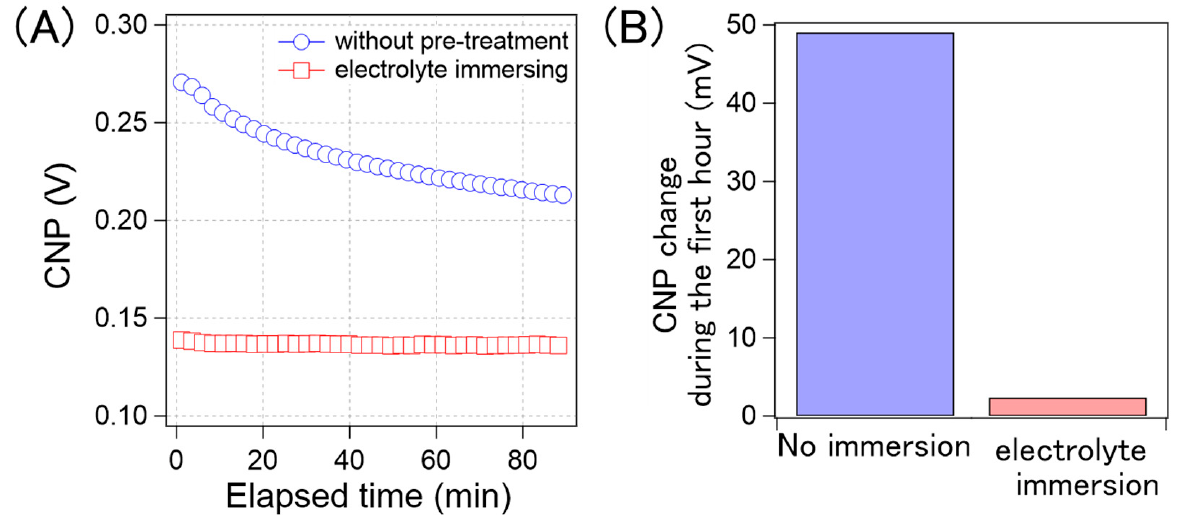
Figure 9. ( A ) Time-course of the calculated average CNP of the GFETs without the pre-treatment (blue circle) and with the electrolyte immersing (red square); ( B ) the CNP shift amount of the GFETs without the pre-treatment and with the electrolyte immersing during the first hour.